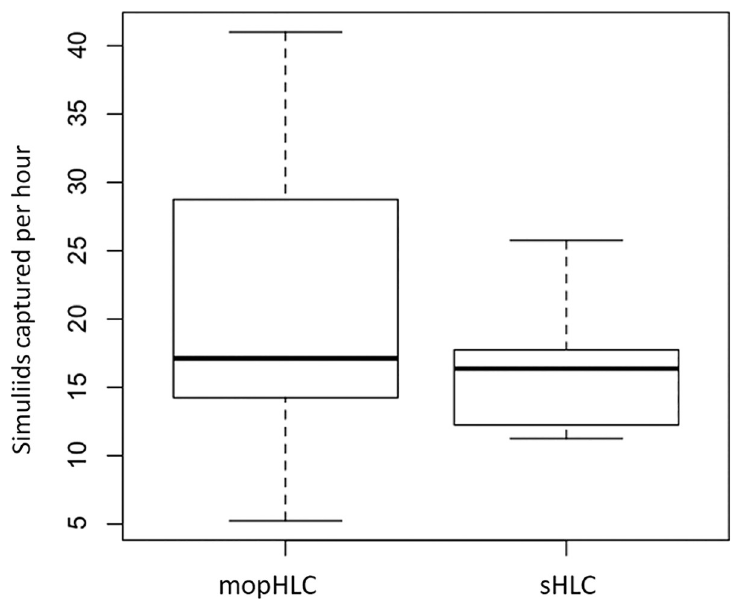
Fig 4. Shows a trapping efficiency comparison between mopHLCs and sHLCs. The raw data used to prepare these box plots is shown in Tables 1 and 2 and derives from six vector collectors who performed both collection techniques simultaneously on the 26th of October 2017. The Y-axis of the graph shows the efficiency with which simuliids were trapped in units of “simuliids captured per hour”.